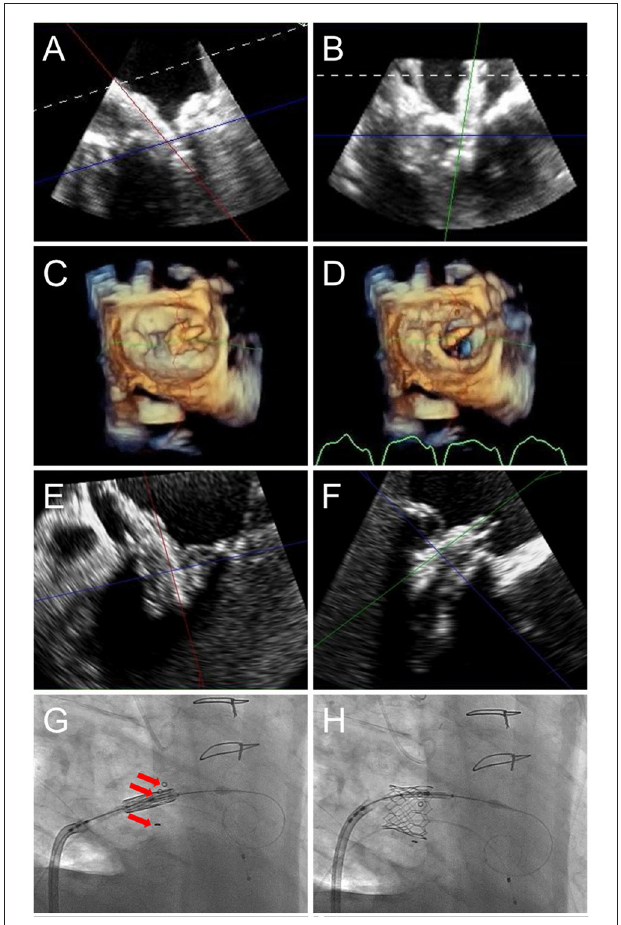
FIGURE 8 | TMVR device positioning. As the orientation of the device may differ from that of the ultrasound plane, live TEE 3D MPR is helpful to properly assess positioning in regards to a calcified mitral annulus (ViMAC) or prior surgical ring (ViR) (A,B) . Valve deployment can also be visualized in an en-face surgeon’s view ( C,D, see Supplementary Video 2 ). In the case of a valve in valve implantation, a 26mm Sapien S3 valve is seen being positioned inside a 29mm bioprosthetic surgical valve in 3D MPR (E,F) , confirming alignment of the ventricular edge of the THV valve frame with the ventricular edge of the existing bioprosthesis which can be identified in fluoroscopy ( G , red arrows). During deployment (H) , the THV shortens predominantly from the inflow (atrial) side, leading to its final position. Supplementary Video 2 demonstrates THV deployment in live 3D MPR.